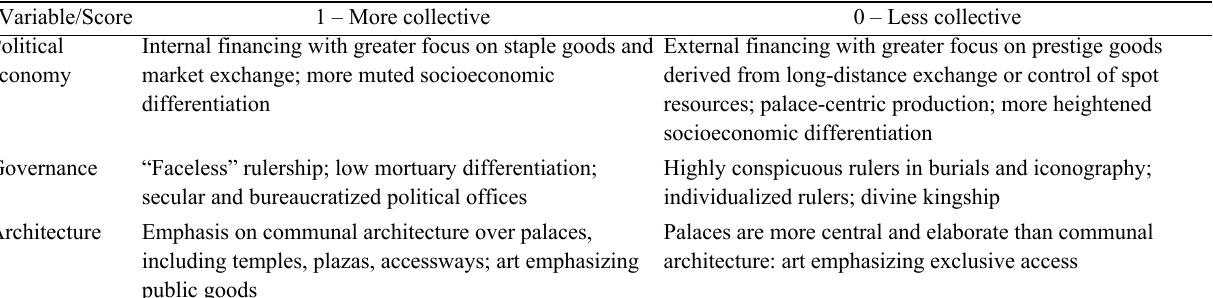
Table 4 Axes of collectivity † coded for Mesoamerican cases.